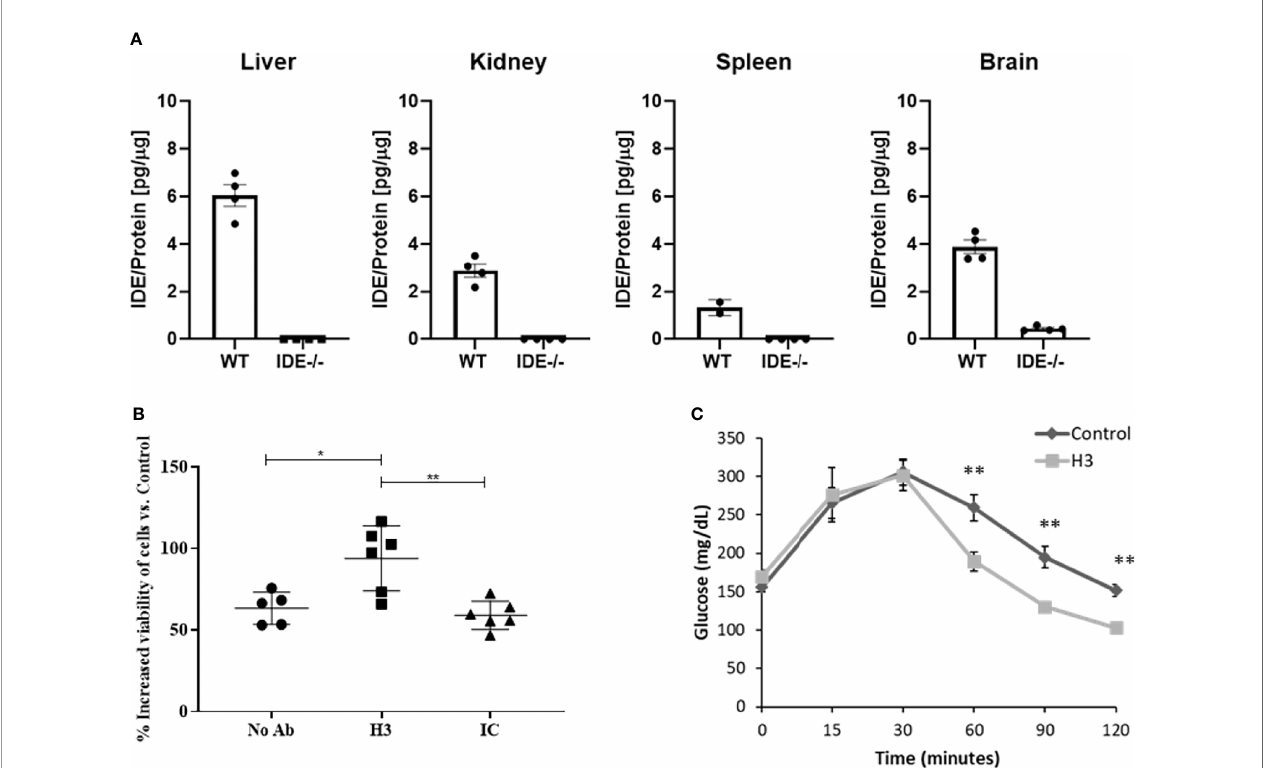
FIGURE 3 | Evaluation of binding speci fi city of human H3 IgG to tissue-expressed IDE and its activity in cell culture and in mice. (A) IDE levels in the liver, kidney, spleen, and brain protein extracts of WT and IDE − / − mice were measured by ELISA. There was no detectable quantity of IDE from any organ in IDE − / − mice. The results are presented as mean ± SEM (n = 4). (B) Anti-IDE human H3 IgG protects HepG2 cells from oxidative stress. HepG2 were treated with 5 m M Rotenone for 4 h. Then, media were discarded, and cells were left to recover overnight with 1 m M antibody treatment as indicated. Twenty-four hours later, cell viability was determined by XTT-based cell proliferation kit. The results are presented as mean ± SD (One way ANOVA; *p = 0.0078; **p = 0.002). (C) Thirty minutes before oGTT, 6-month-old male mice received a single i.p. injection of scFv at concentration of 2 mg/ml (20 mg/kg) or PBS (control). Blood glucose was measured before glucose administration (0) and 15, 30, 60, 90, and 120 min after. The results are presented as mean ± SEM (n = 5). **p < 0.01. One-way ANOVA with Bonferroni correction was